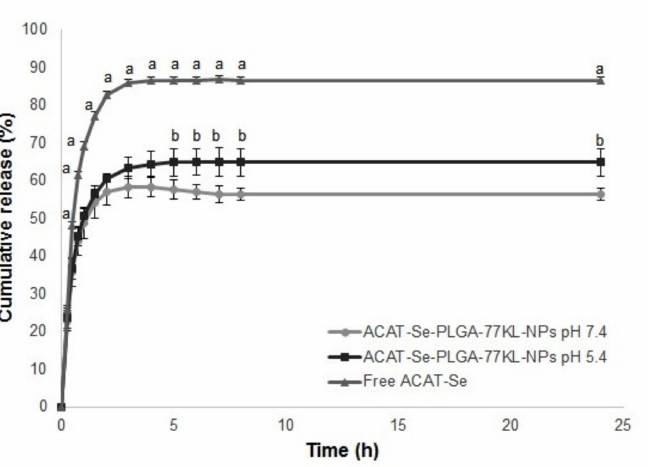
Figure 1. In vitro release of free and nanoencapsulated ACAT-Se. Results are expressed as mean ± SE of three independent experiments. Statistical analyses were performed using ANOVA, followed by Student–Newman–Keuls multiple comparison test. a Significant difference between Free ACAT-Se and ACAT-Se-PLGA-77KL-NPs (p < 0.05), b between PLGA-77KL-NPs pH 7.4 and 5.4 ( p <